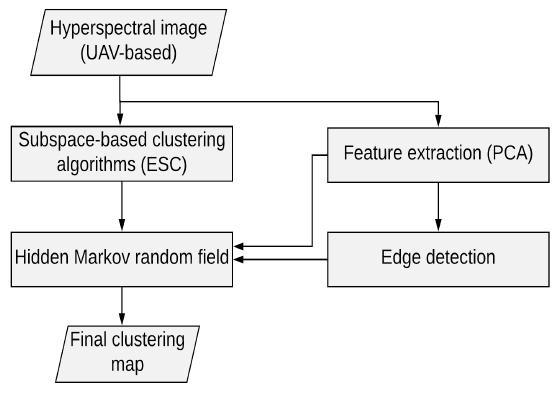
Figure 1. The flowchart of the proposed spectral-spatial